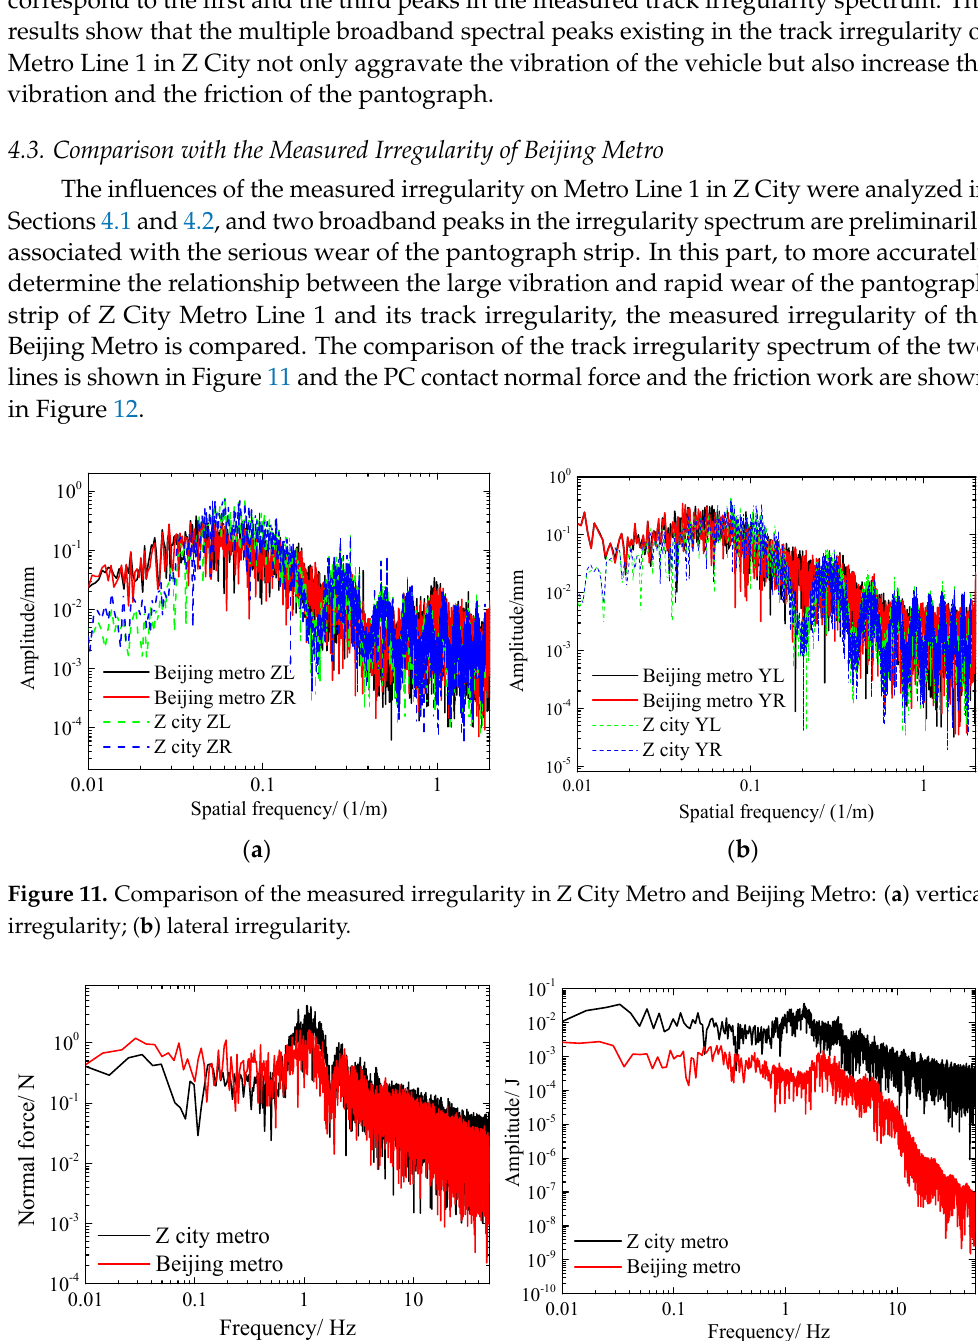
( b ) Figure 10. PC contact force under two speeds: ( a ) normal force; ( b ) friction force.